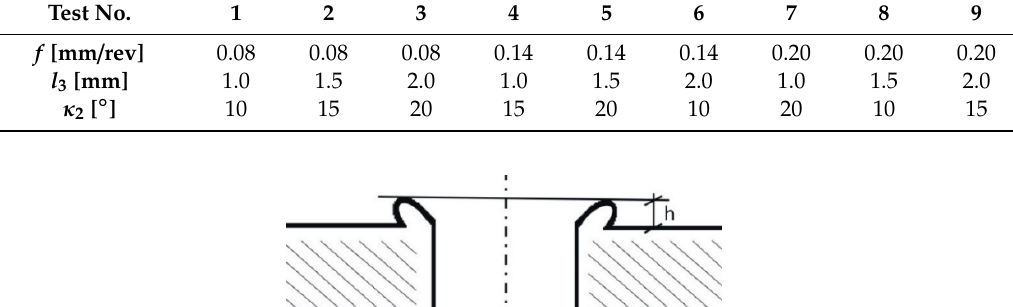
Table 4. Experiment plan developed according to Taguchi method.